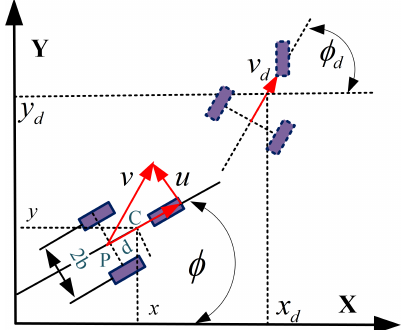
Figure 1. Overview of the differentially driven wheeled mobile robot